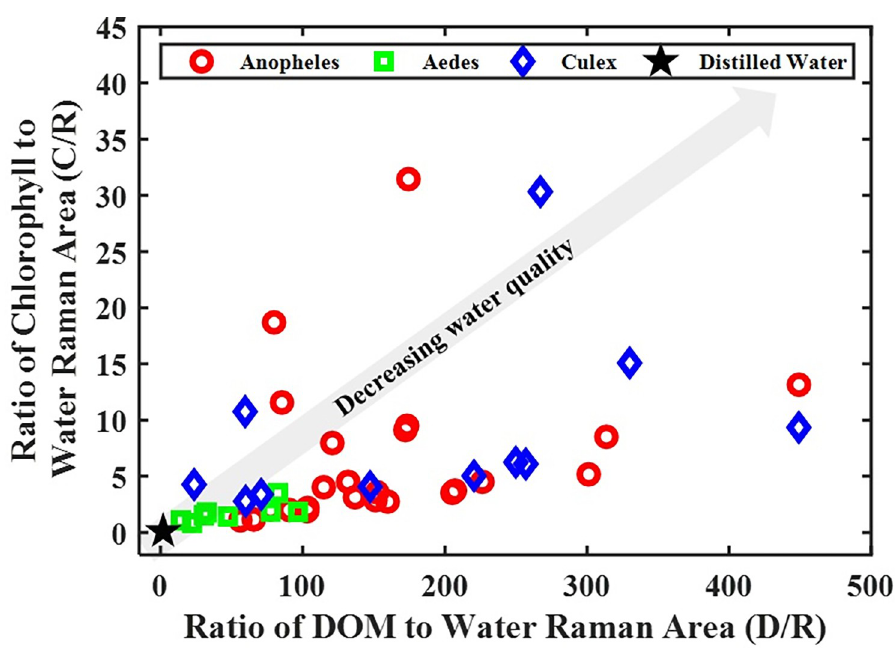
Fig 5. The relationship between the Chlorophyll to water Raman band ratio (C/R) and DOM to water Raman band ratio (D/R) for water samples from the mosquitoes’ various breeding habitats. It enables the determination of the water quality of the samples from multiple breeding